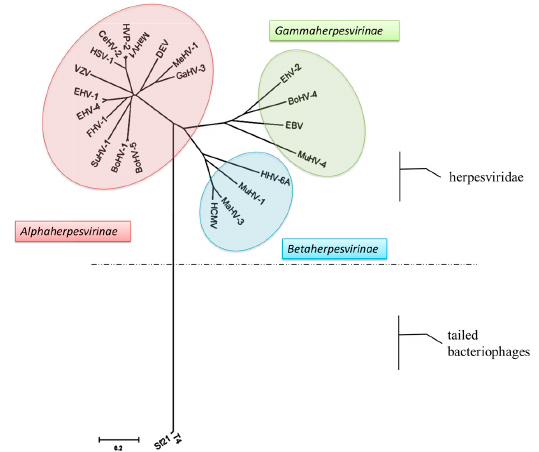
Figure 2. Phylogenetic tree based on the pUL15s sequence of 21 herpesviruses and 2 bacteriophages. The phylogenetic tree was constructed using MAGE7. The pink color represents the α -herpesvirus subfamily, the blue represents the β -herpesvirus subfamily, and the green represents the γ -herpesvirus subfamily. The dotted line above represents the herpesvirus family virus, and below the dotted line represents the phage. The 0.2 below the evolutionary tree represents the evolutionary distance. Viruses 2018 , 10 , x FOR PEER REVIEW